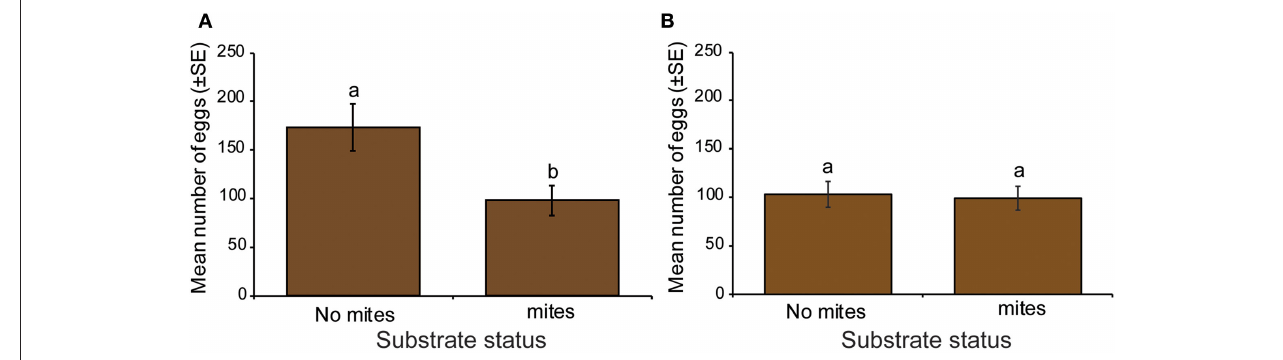
FIGURE 2 | Influence of the presence of the mite Macrocheles muscaedomesticae on oviposition decisions by S. calcitrans . (A) Bar chart depicting the mean number of eggs laid by S. calcitrans on substrates with and without mites under light (Paired t -test, P < 0.05, n = 10). (B) Bar chart depicting the mean number of eggs laid by S. calcitrans on substrates with and without mites in darkness (Paired t -test, P > 0.05, n = 10). Error bars indicate the standard error of the mean. Treatments with different lowercase letters are significantly different from each other.